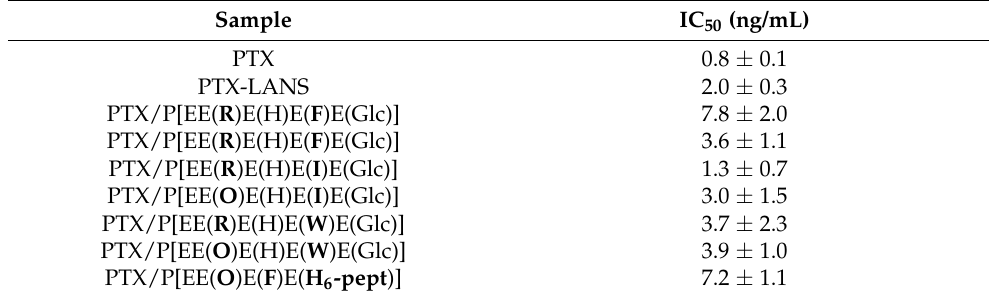
Table 4. Cytostatic effect of the developed PTX nanoformulations (A549 cell line, 72